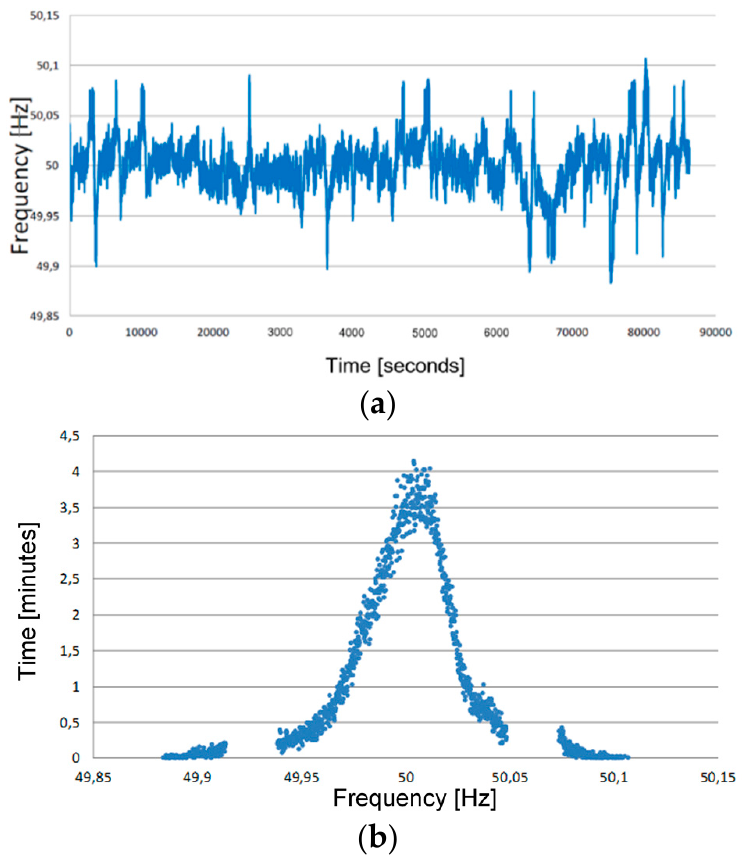
Figure 2. ( a ) frequency behaviour in a real network bus used for regulation frequency cycle; ( b ) frequency distribution during a regulation frequency cycle.